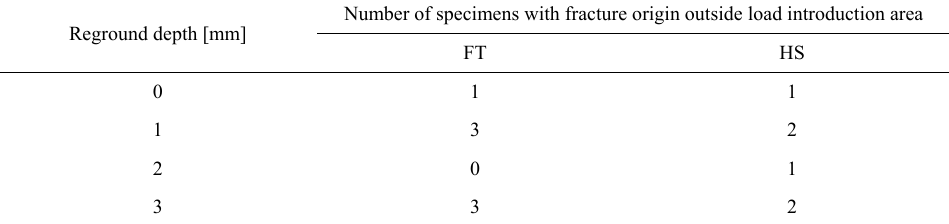
Table 3: Specimens with fracture origin outside the load introduction area